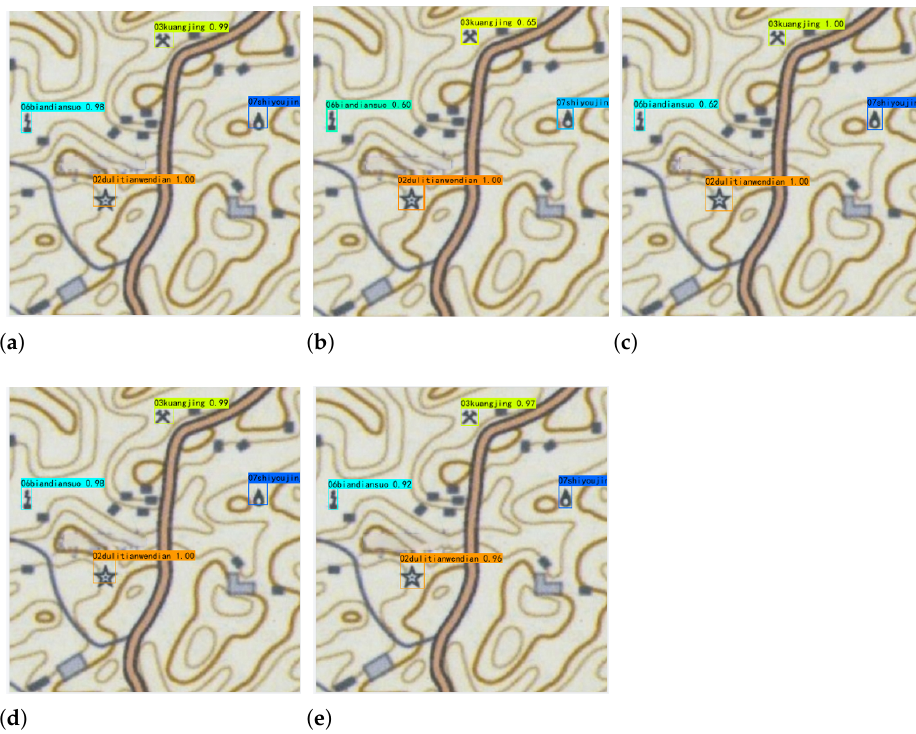
Figure 14. Results obtained by different models for Map B: ( a ) faster R-CNN, ( b ) VGG-SSD,